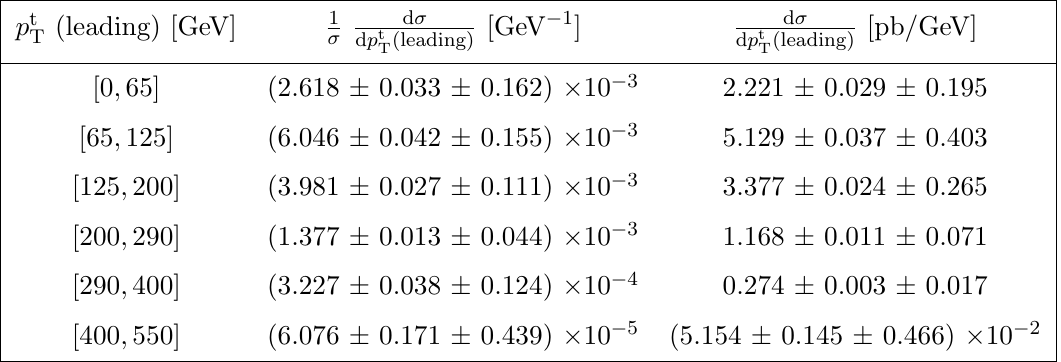
Table 3 . The measured di(cid:11)erential cross section and bin boundaries for each bin of the normalized and absolute measurements of the tt di(cid:11)erential cross section at parton level in the full phase space as a function of p t (leading) are tabulated. T